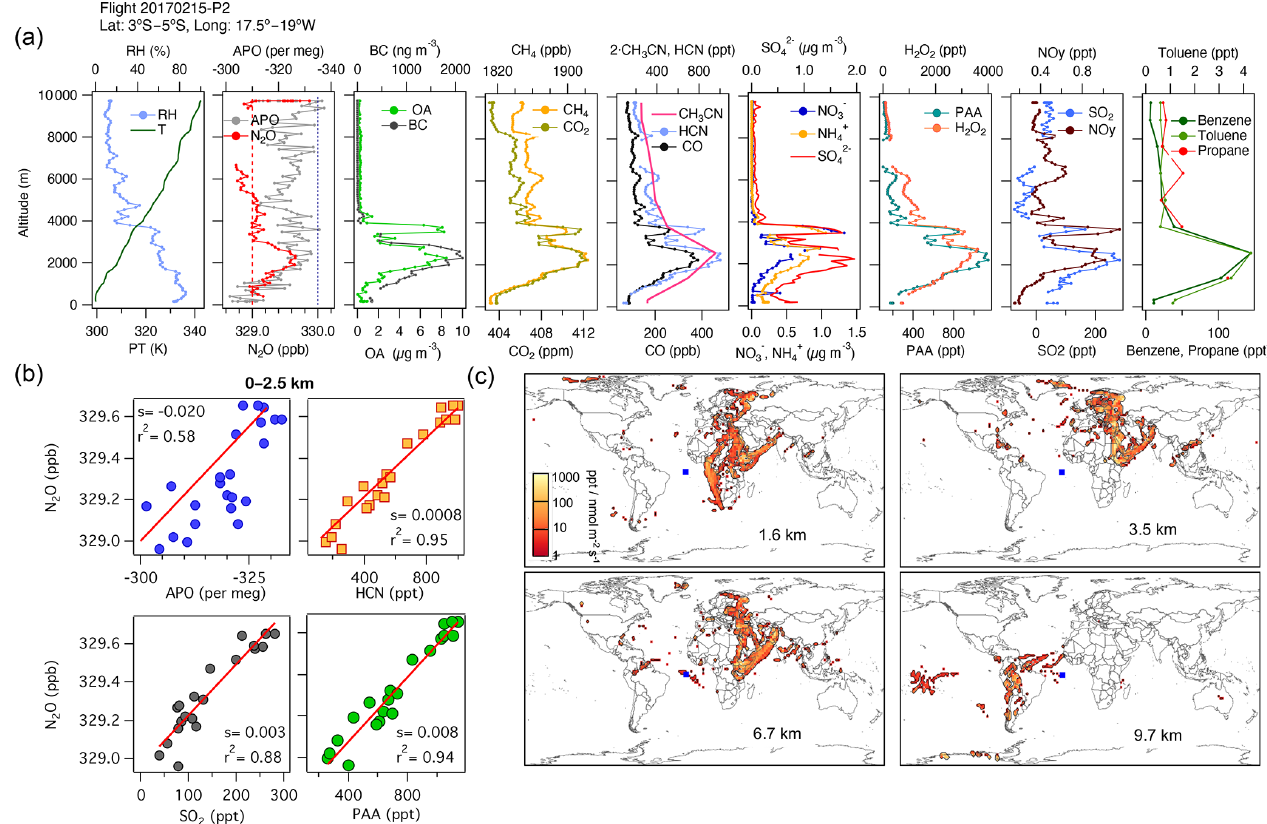
Figure 8. (a) Vertical profiles of PT, RH, and the tracers N 2 O, APO, organic aerosols (OA), black carbon (BC), CH 4 , CO 2 , CO, HCN, CH 3 CN, NO − , NH + , SO 2 + , H 2 O 2 , PAA, SO 2 , NO y , benzene, toluene, and propane from profile 2 on 15 February 2017. The dotted blue 3 4 4 line in the plot of APO and N 2 O represents the NOAA-MBL reference (N 2 O-MBL) at the latitude of the flight, and the red dashed line shows the NOAA-MBL at the origin of the southern air masses shown by the footprints below 2km (20 ◦ S). (b) Correlations between N 2 O and APO, HCN, and SO 2 for data observed below 2.5km indicate an admixture of marine, biomass-burning, urban, and oil and gas industry contributions to N 2 O mixing ratios ( s represents the slope of the linear fit). (c) Footprint maps tracing surface regions that influence mixing ratios measured in the altitude ranges 0–2, 2–3, 3–4, and 4–7 km, respectively. Blue squares show sampling locations. Values below 3pptnmol − 1 m 2 s are not included in the footprint plot. Note that the APO axes are